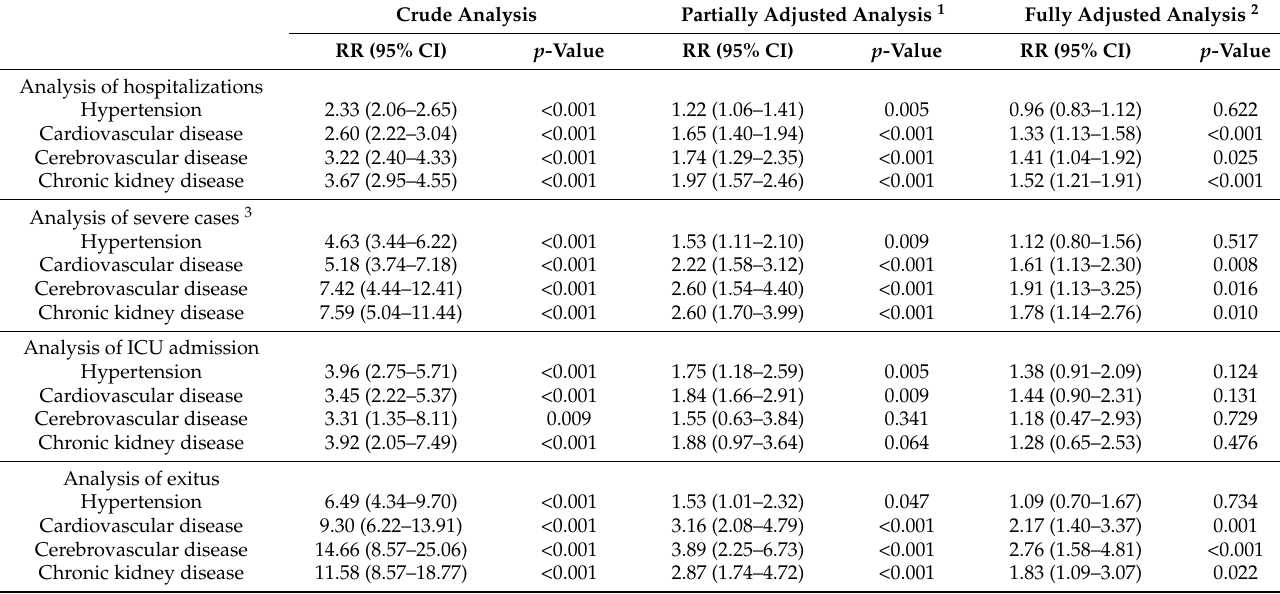
Table 3. Association of hypertension and hypertension-related conditions (cardiovascular, cerebrovascular or chronic kidney diseases) with COVID-19 outcomes.